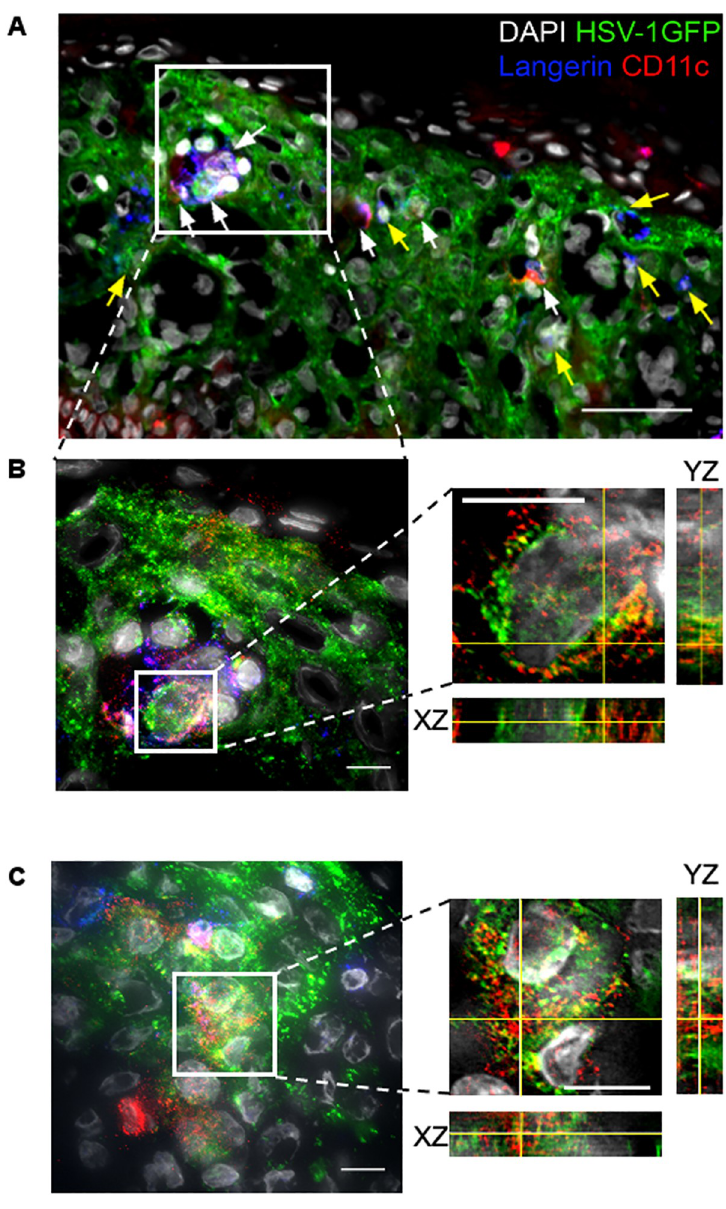
Fig 1. Interaction of LCs and Epi-cDC2s with HSV-1 in the epidermis of inner foreskin explants. Inner foreskin explants were topically infected with HSV-1 GFP or mock infected for 24 h, snap-frozen and cryo-sectioned prior to immunofluorescent labelling with anti-Langerin (blue) and anti-CD11c (red) antibodies and DAPI staining. (A) Image from a 9 y.o. donor shows LCs (Langerin + CD11c - , blue cells) and Epi-cDC2s (CD11c + Langerin +/- , red and red/blue dual labelled cells) in the epidermis of an HSV-1 GFP infected (green) foreskin explant at 20x magnification. Arrows indicate Epi-cDC2s (white arrows) and LCs (yellow arrows) interacting with HSV-1 GFP infected keratinocytes or that appear to be HSV-1 GFP + . This image is representative of the observations in three donors. Scale bar = 50 μ m. (B) The same representative donor re-imaged at 60x magnification to generate Z-stacks with 0.1 μ m Z spacing. The left panel shows the maximum intensity projection of 49 slices of a region of interest, indicated by the white box in (A). The right panel shows the orthogonal view of the XZ and YZ planes of an individual CD11c + cell containing HSV-1 GFP + labelling. Scale bar = 10 μ m. (C) A 5 y.o. donor imaged as in (B) with the maximum intensity projection of 50 slices shown on the left and the orthogonal view of a CD11c + cell containing HSV-1 GFP + labelling on the right. Scale bar = 10 μ m.